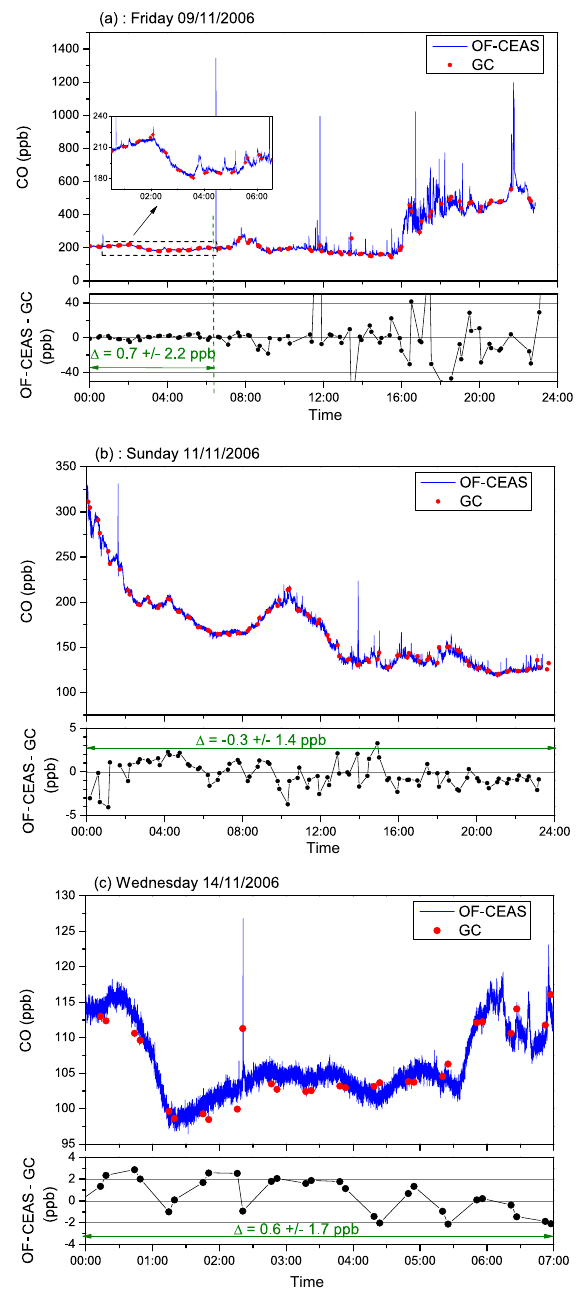
Figure 2. Two days and one night monitoring of atmospheric con- centration in Gif-sur-Yvette selected for their different ranges. CO values are given in dry air mole fraction. The GC data are time- shifted by 14min in order to eliminate the time delay between the two instruments. Upper graphs in each panel: OF-CEAS measure- ments are averaged for 2s while GC measurements are performed twice an hour. Lower graphs in each panel: difference of the mea- surements after averaging OF-CEAS data for 1 minute around the GC time measurement. Mean values of the difference and standard deviations are written in